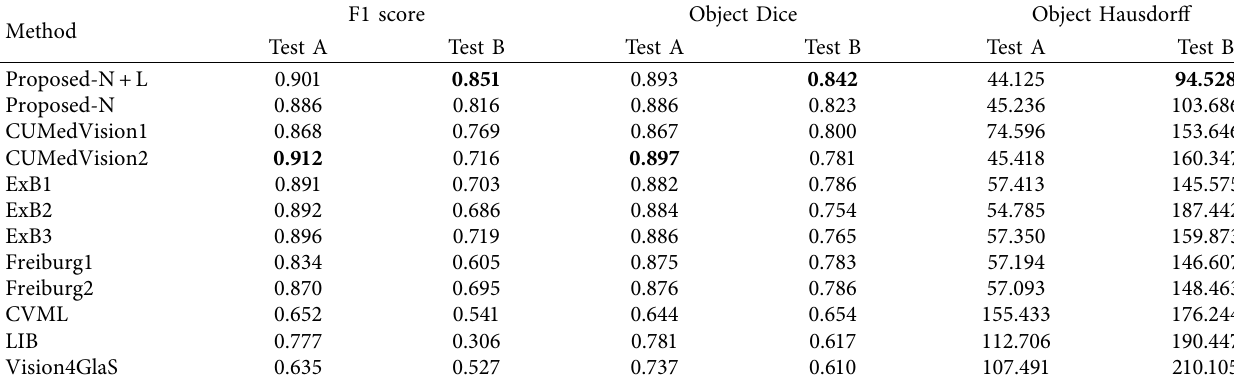
Table 1: Comparing results of different competition algorithms on the public GlaS dataset.